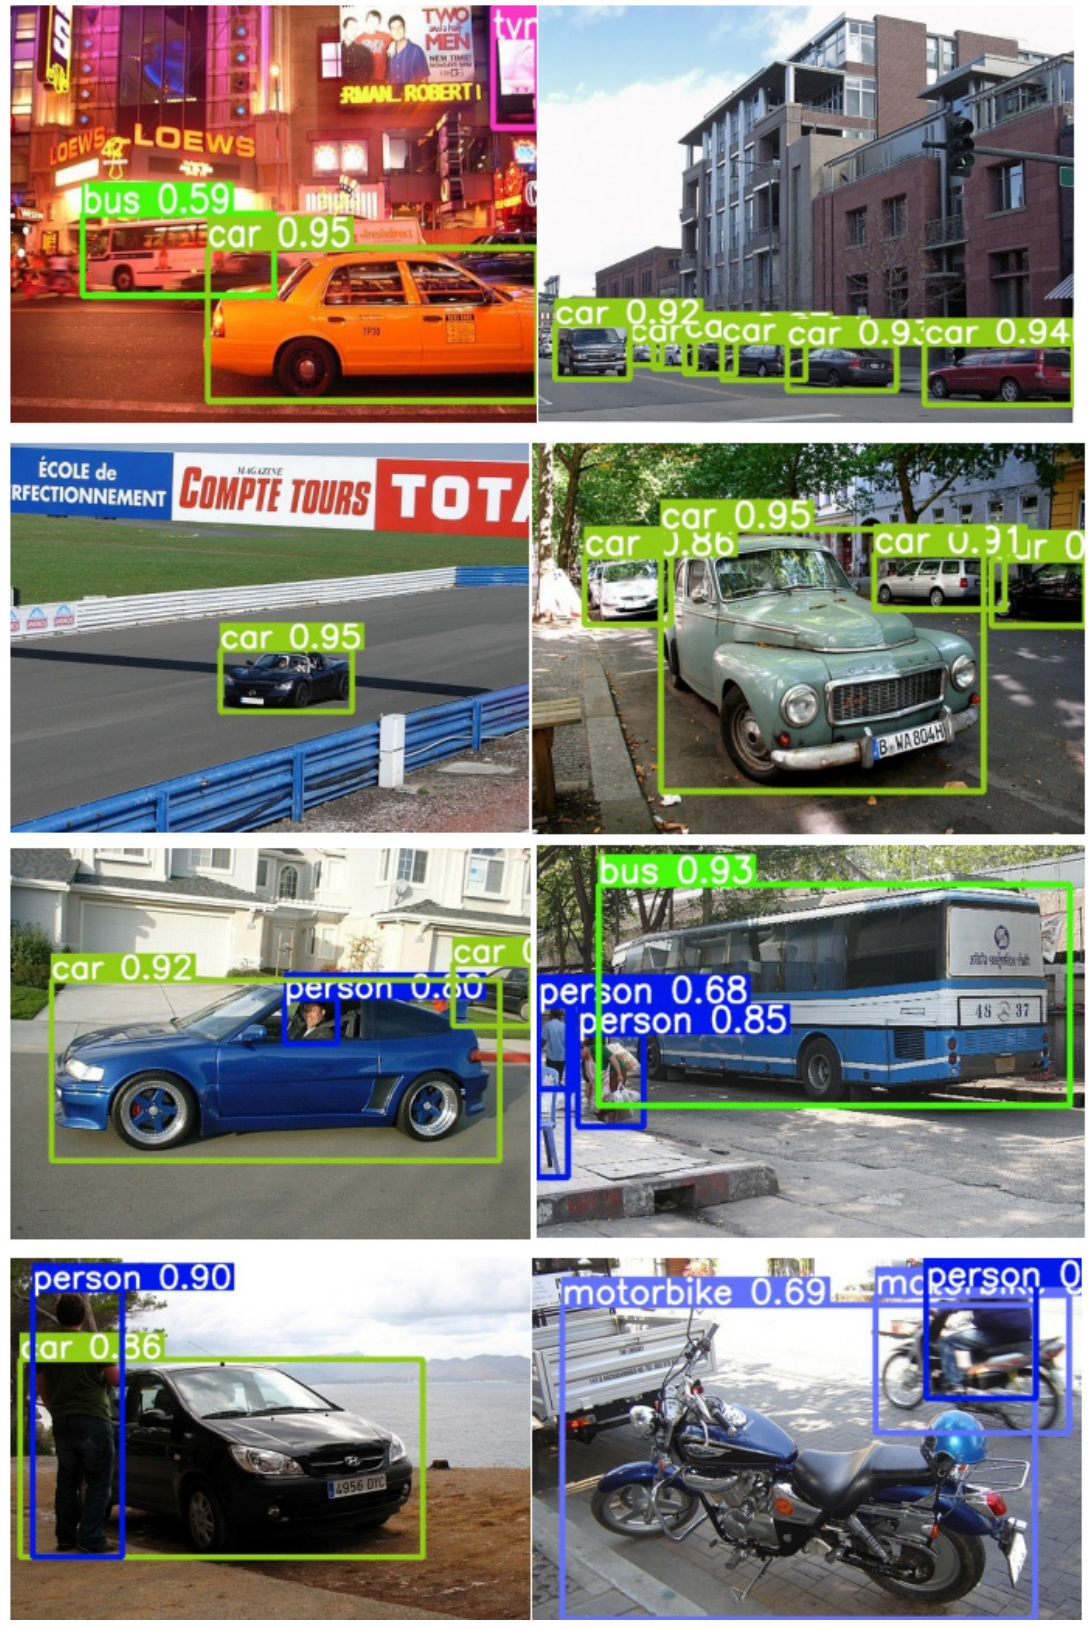
Figure 9. Results on the VOC2007 + 2012 dataset.